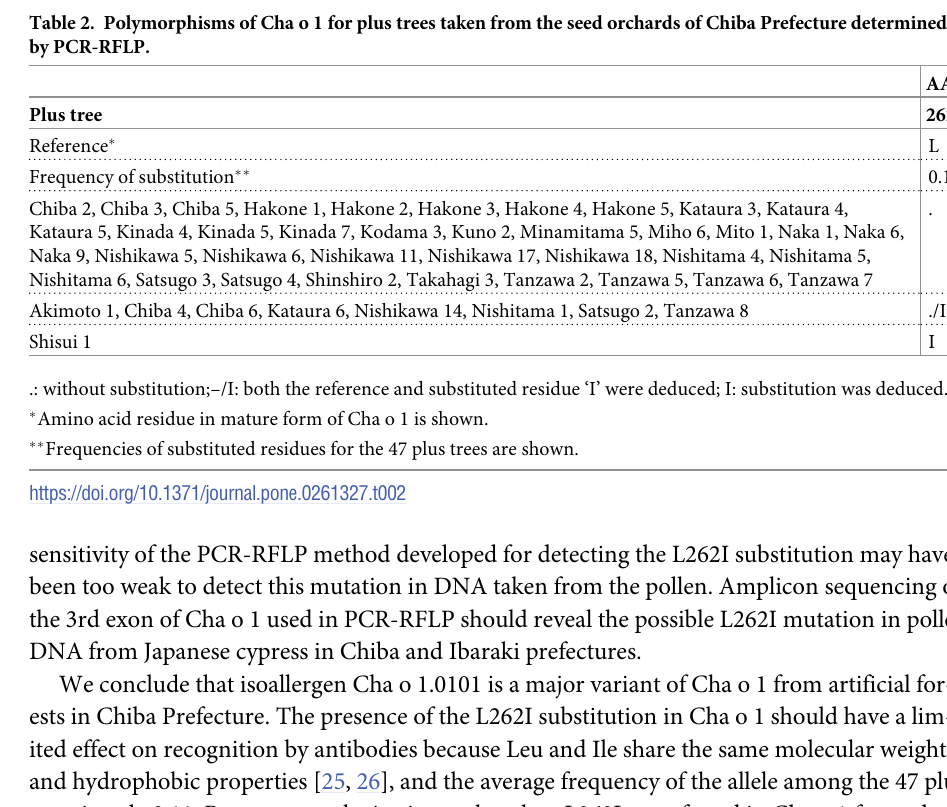
Table 2. Polymorphisms of Cha o 1 for plus trees taken from the seed orchards of Chiba Prefecture determined by PCR-RFLP. Plus tree 262